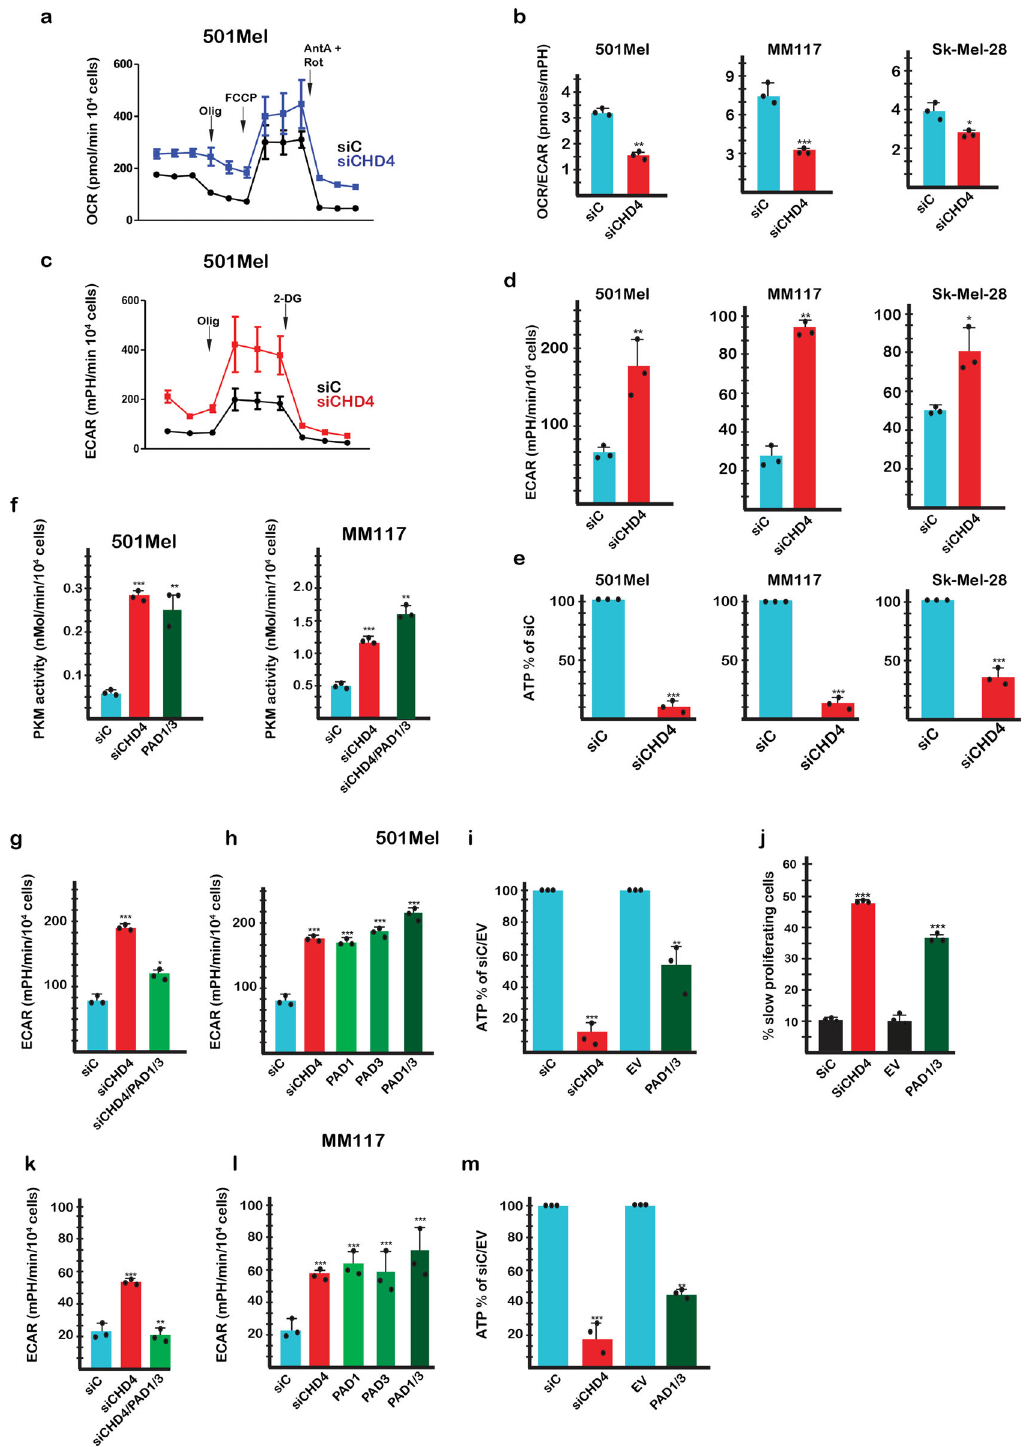
Fig. 3 CHD4 silencing regulates glycolysis and cell proliferation. a Effect of CHD4 silencing on basal and maximal OCR values in 501Mel cells. b Effect of CHD4 silencing on the basal OCR/ECAR ratio in the indicated cell types. c , d Effect of CHD4 silencing on basal and maximal ECAR values in 501Mel cells and basal ECAR values in the indicated cell types. e CHD4 silencing reduces intracellular ATP levels in the indicated cell lines. f Stimulation of PKM2 enzymatic activity in extracts from cells under the indicated conditions. g , h ECAR values in 501Mel cells following transfection with indicated siRNAs or expression vectors. i Intracellular ATP levels following CHD4 silencing or PAD1/3 expression. EV = empty expression vector control. j Reduced cell proliferation following PAD1/3 expression. k – m ECAR values and intracellular ATP levels in MM117 cells following transfection with indicated siRNAs or expression vectors. ECAR and OCR and ATP values were determined from n = 3 biological replicates with 6 technical replicates for each N in the case of OCR and ECAR. n = 3 biological replicates and unpaired t -test with two tailed p -value analyses and con fi dence interval 95% were performed by Prism 5. p -Values: * p < 0.05; ** p < 0.01; ***p < 0.001. Data are mean ± SEM. Values for PKM2 enzymatic activity were determined by Prism 5 using a 2-way ANOVA